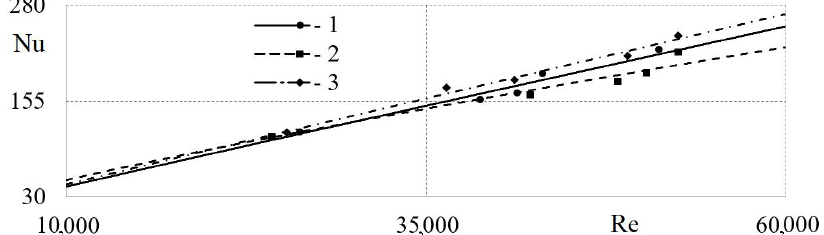
Figure 12. Dependences of the Nusselt number Nu on the Reynolds number Re in the intake system with channels of different diameters: 1— d = 26 mm; 2— d = 32 mm; 3— d = 40 mm.